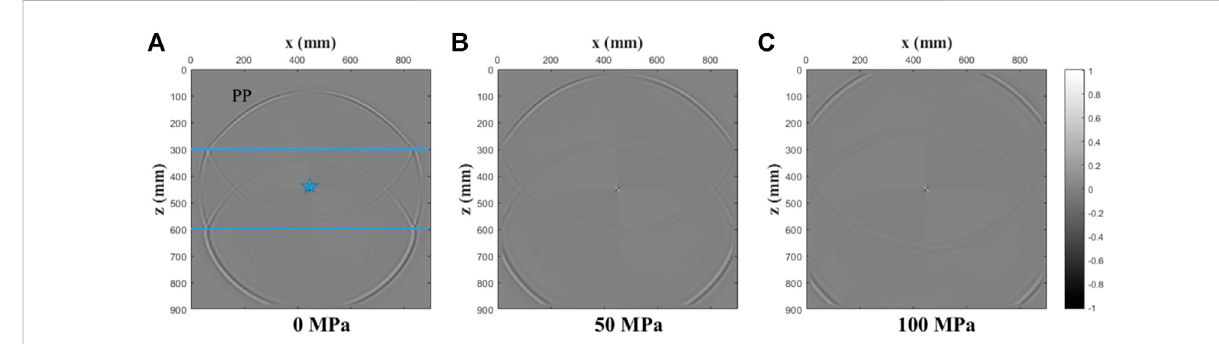
FIGURE 17 DecoupledP-wave fi eldsnapshotsofthe x -componentat t =0.1 msforathree-layermodelundervariouscon fi ningstresses( (A) :0MPa; (B) :50 MPa; (C) : 100 MPa). The location of the source is marked by a star in the fi gure. The consecutive wavefronts include P-wave (P), and P-wave re fl ection (PP).